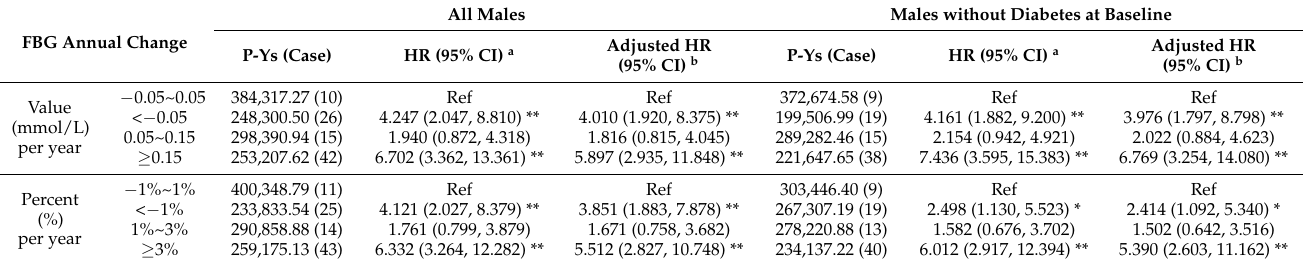
Table 2. Hazard ratios (HRs) for the association between FBG annual change and pancreatic cancer risk.